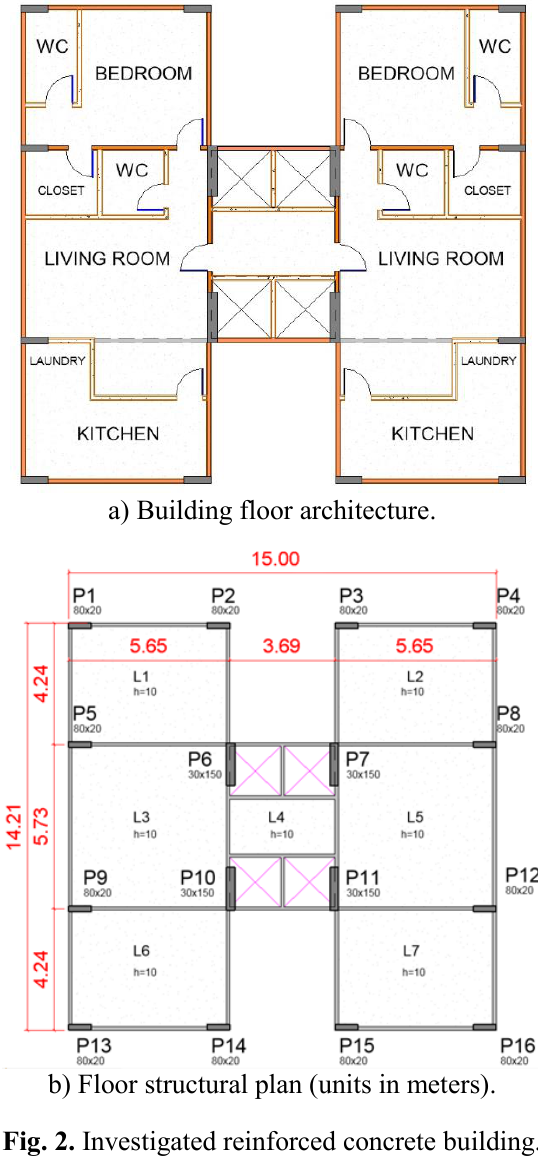
Fig. 2. Investigated reinforced concrete